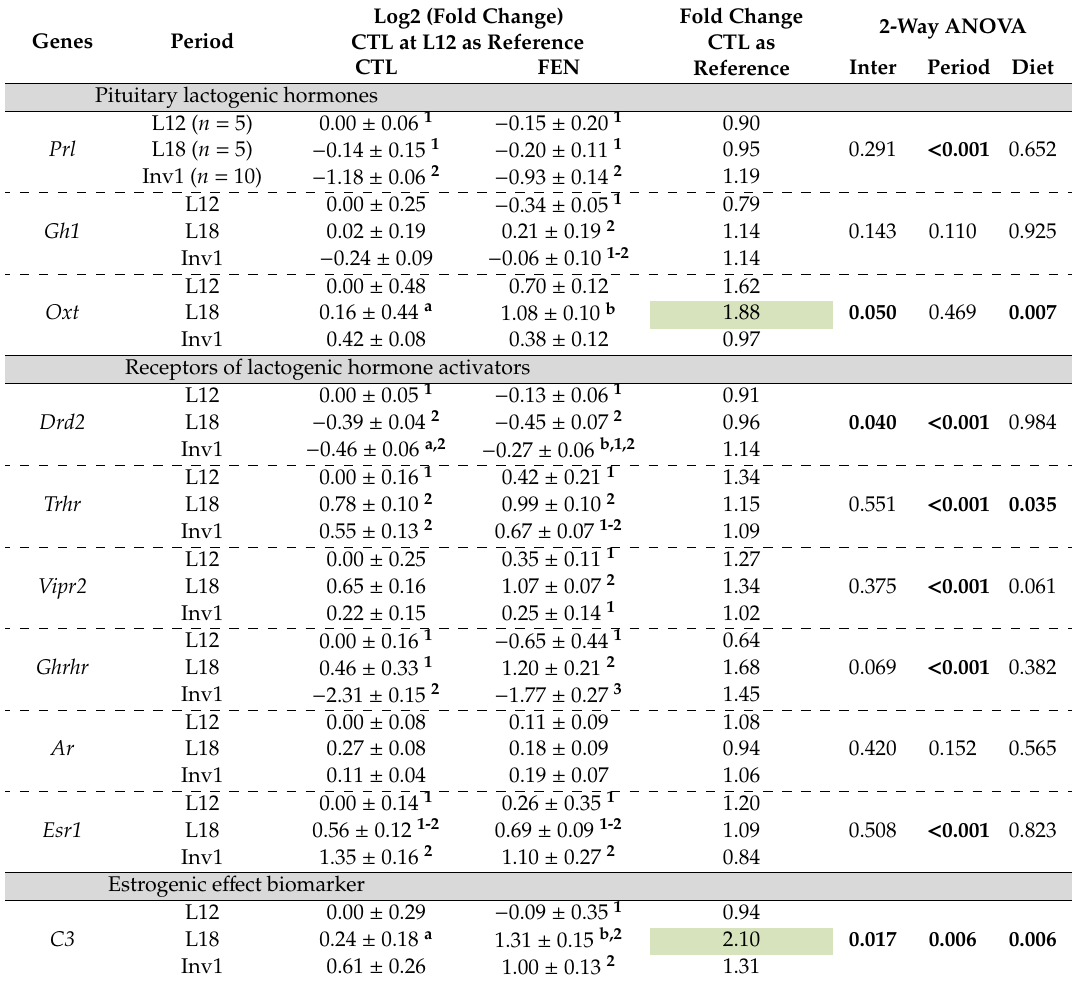
Table 6. E ff ect of fenugreek on relative expression of lactogenic hormone-related genes in pituitary gland along lactation